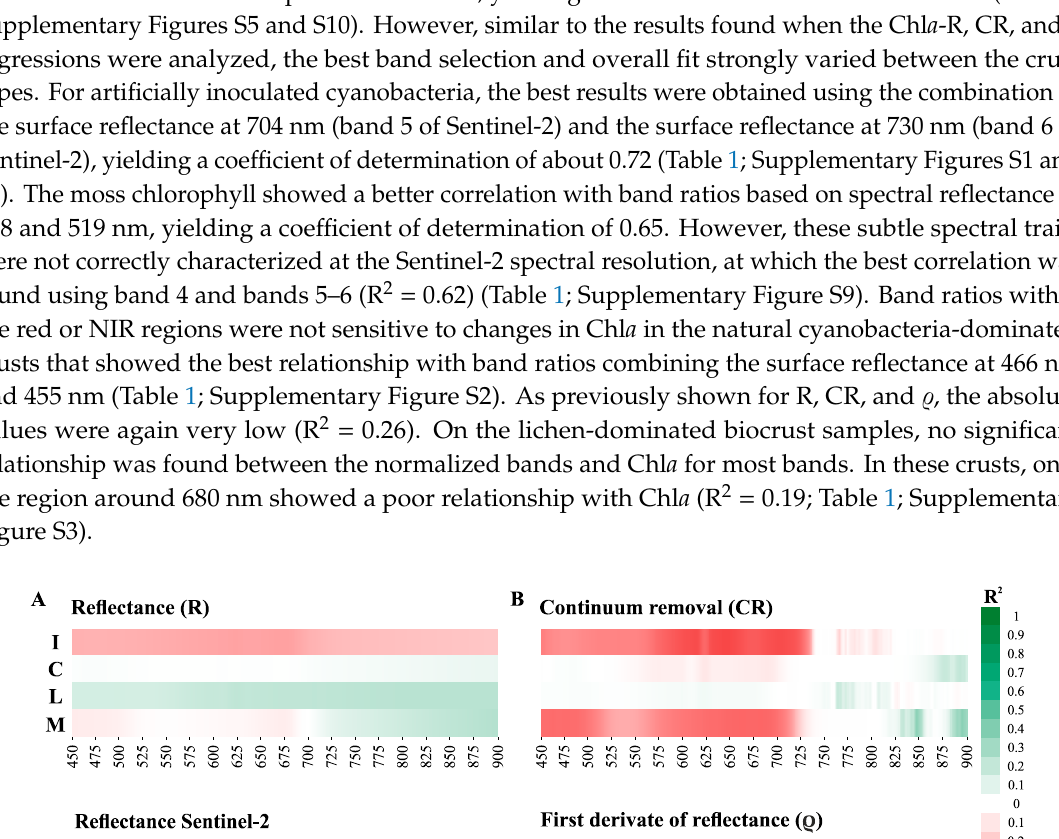
Figure 7. Comparing the coefficient of determination (R 2 ) between: ( A ) reflectance calculated with the hyperspectral data (R) and reflectance calculated with Sentinel-2 resampled data and chlorophyll a concentrations for each biocrust type; and ( B ) continuum removal (CR), and first derivate of reflectance ( ρ ) and chlorophyll a concentrations for each biocrust type calculated with the hyperspectral data. I: incipient, C: cyanobacteria-dominated, L: lichen-dominated, and M: moss-dominated. Green scale values of the coefficient of determination indicate a positive relationship between the response variable (Chl a ) and predictor factor (spectral information), whereas red scale values indicate a negative relationship.